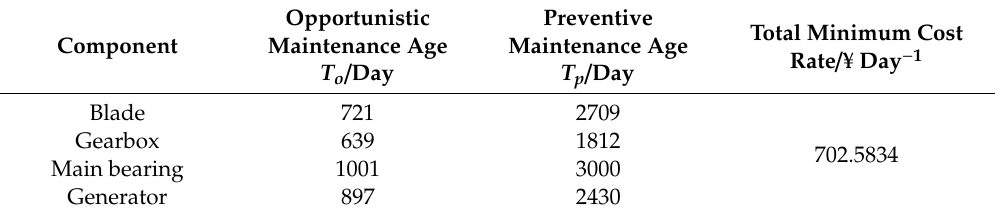
Table 11. Optimization results of the opportunistic maintenance